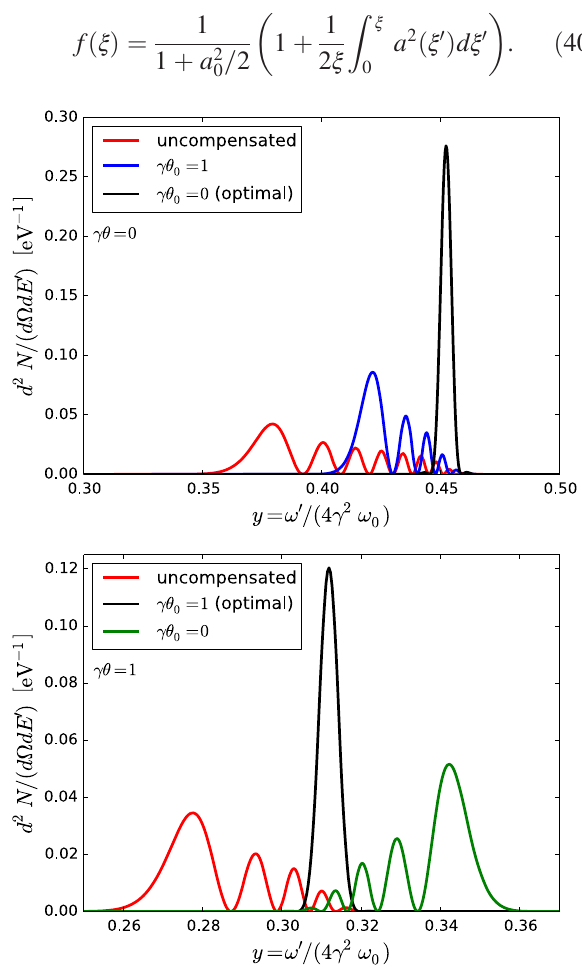
FIG. 4. Top: Radiation spectrum for the compensated nonlinear Compton backscattering ( θ ¼ 0 ). The optimally compensated spectrum shown in black for θ 0 ¼ θ is much narrower than the uncompensated spectrum (red line) and partially compensated spectrum (blue line), where the optimization angle θ 0 does not coincide with the scattering angle θ . Bottom: Radiation spectra for the compensated nonlinear Compton scattering at an angle θ ¼ 1 = γ and ϕ ¼ π = 2 . The optimally compensated spectrum is shown in black for θ 0 ¼ θ ¼ 1 = γ , uncompensated in red and the spectrum for which the optimization angle does not coincide with the scattering angle ( θ 0 ¼ 0 ) in green. Top and bottom panels are to be compared with Figs. 2(a) and 2(b) from Ref. [8], respec- tively. Our spectra assume both positive and negative frequencies exist in the spectra; Ref. [8] assumes positive frequency only and is therefore a factor of 2 higher. Both plots are for the head-on scattering of a linearly polarized 800 nm laser with pulse duration of 21 fs and a 0 ¼ 1 on an electron beam with initial energy 51 GeV. A Gaussian laser envelope is